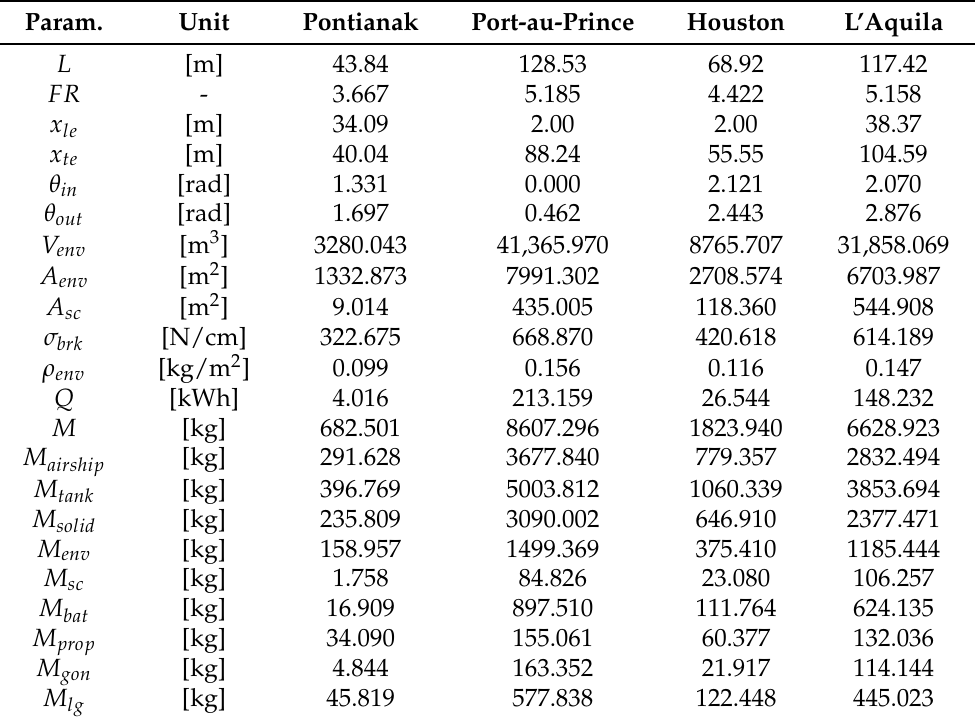
Table 8. Comparison between HAPS optimal designs for operation at 20 km altitude above the four considered